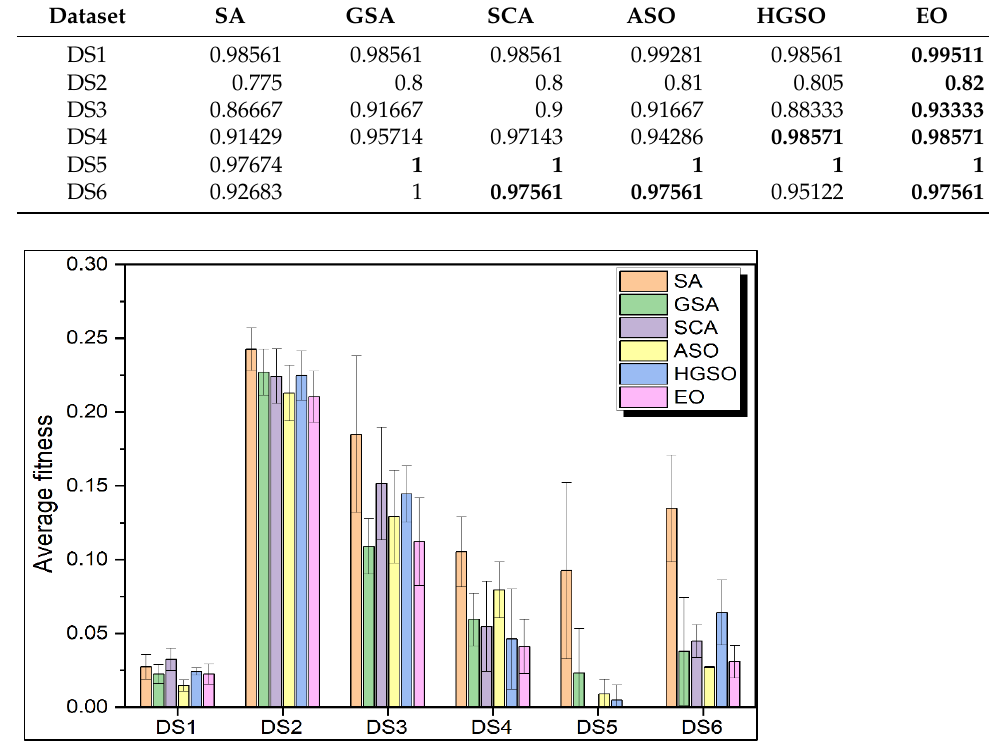
Table 4. Best classification accuracy of all algorithms.